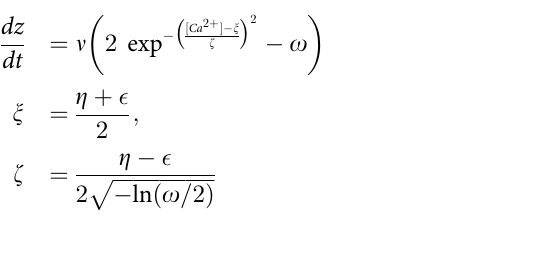
Fig 1. Overview of the model. ( A ) Excitatory (E) and Inhibitory (I) neurons ( N connected via synapses with a connection probability of ( p = 0.02). All synapses (EE, EI, II), other than IE synapses, which are modulated by inhibitory spike-timing dependent plasticity, are static with conductances g respectively. All synapse sets are modifiable by the structural plasticity mechanism. External Poisson spike stimuli are provided to all excitatory and inhibitory neurons via static synapses with conductances g E simulate deafferentation, the subset of these synapses that project onto neurons in the Lesion Projection Zone (LPZ) (represented by dashed lines in the figure) are disconnected. (B) Spatial classification of neurons in relation to the LPZ: LPZ C (centre of LPZ) consists of 2.5% of the neuronal population; LPZ B (inner border of LPZ) consists of 2.5% of the neuronal population; Peri-LPZ (outer border of LPZ) consists of 5% of the neuronal population; Other neurons consist of the remaining 90% of the neuronal population. (Figure not to scale).